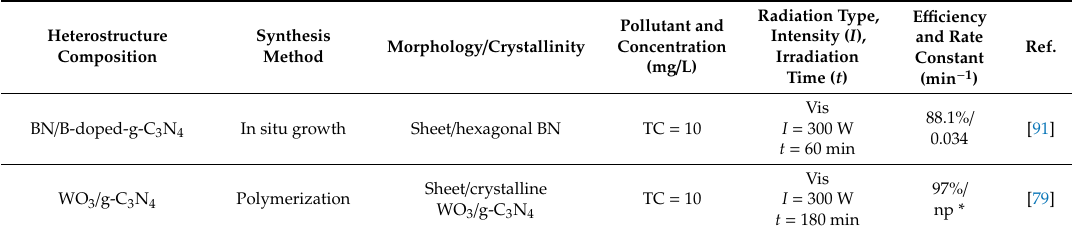
Table 2. Recent representative studies on heterostructures photocatalytic application for pharmaceutical active compounds